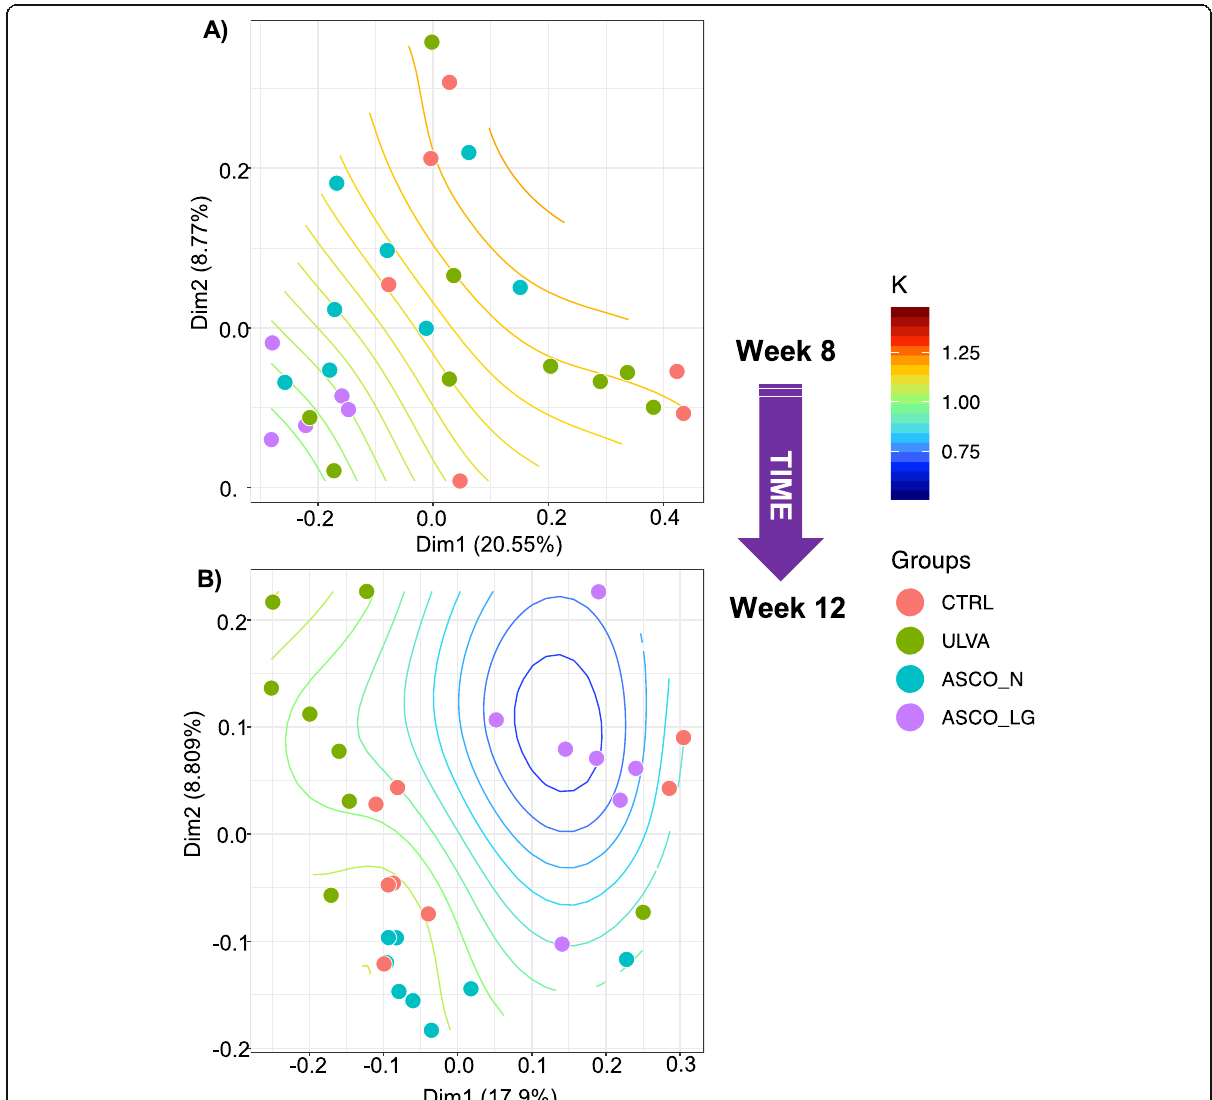
Fig. 5 Unifrac unweighted principal co-ordinate analysis of the gut microbiota of juvenile Atlantic cod ( Gadus morhua ) community composition based on the different dietary treatments (CTRL, ULVA, ASCO_N and ASCO_LG) at a ) Week 8, and b ) Week 12. The values given on each axis (Dim1 or Dim2) indicate the total percentage variation for the treatment groups. Contour lines represent condition factor (K) fit through generalised additive modelling. Deviance in ordination space at Week 8 is explained by 24.5%; R2 = 0.18; * P = 0.043. Deviance in ordination space at Week 12 is explained by 57.8%; R2 = 0.5; *** P =